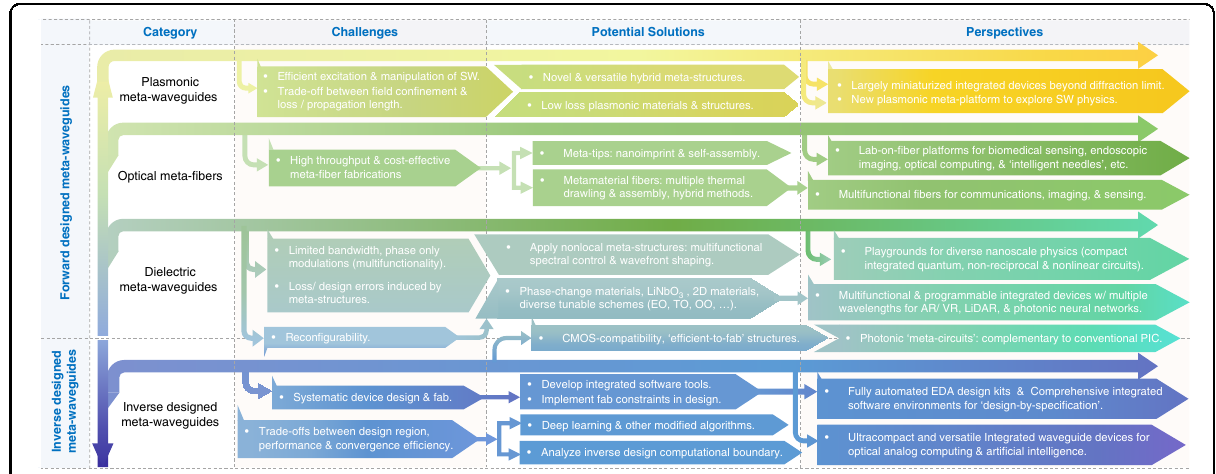
Fig. 14 Roadmap. Current challenges, corresponding potential solutions and perspectives are brie fl y outlined. In the near-term, challenges in systematic device design, multifunctionality and recon fi gurability require attention. For further practical applications, compatible integration and ef fi cient fabrication should be properly